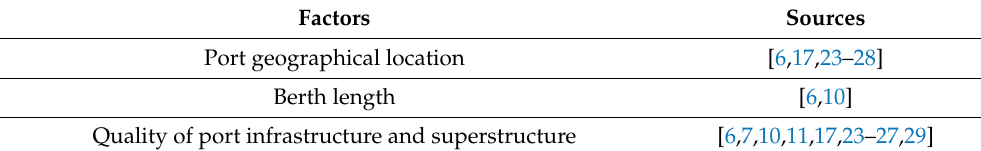
Table 1. Container Seaport Competitiveness Factors.